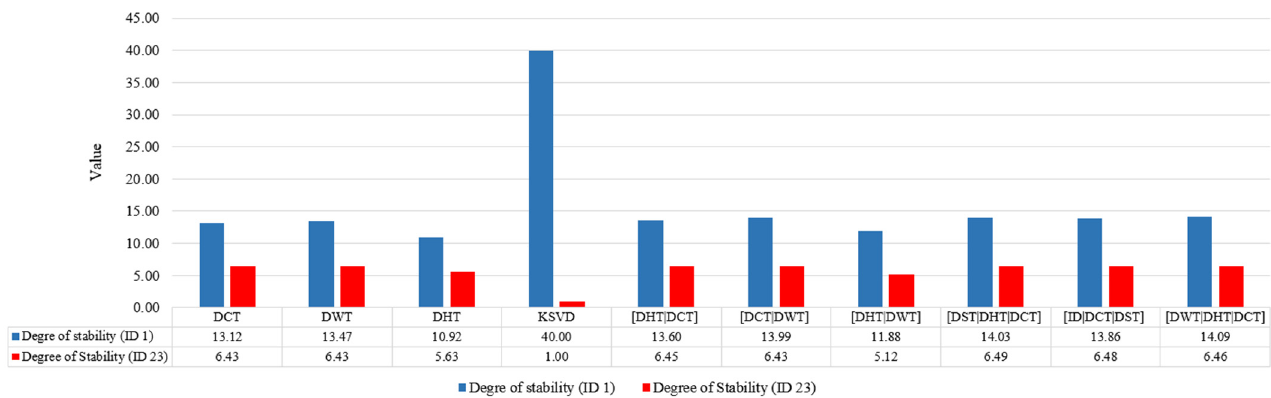
Figure 9. Projections of signals ID 1 and ID 23 on stable and unstable 3H-OHD and ADL.